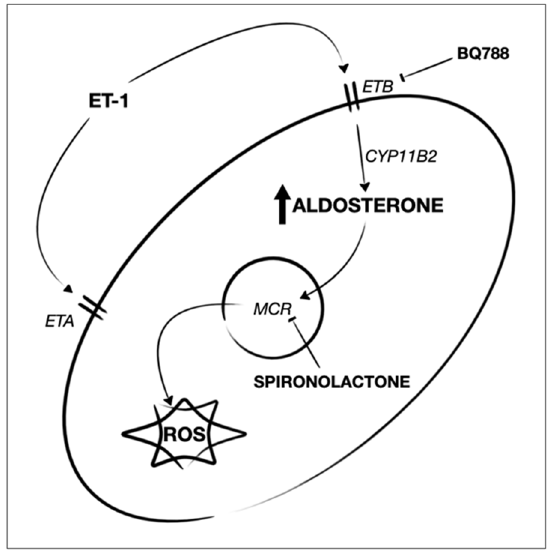
Figure 8. Proposed mechanism. The binding of ET-1 to its ETB receptor activates CYP11B2 increasing aldosterone, which, through its receptor (MCR), induces ROS production in HPFs and SScHDFs. The inhibition of the ETB receptor or the antagonism of MCR arrests this process.